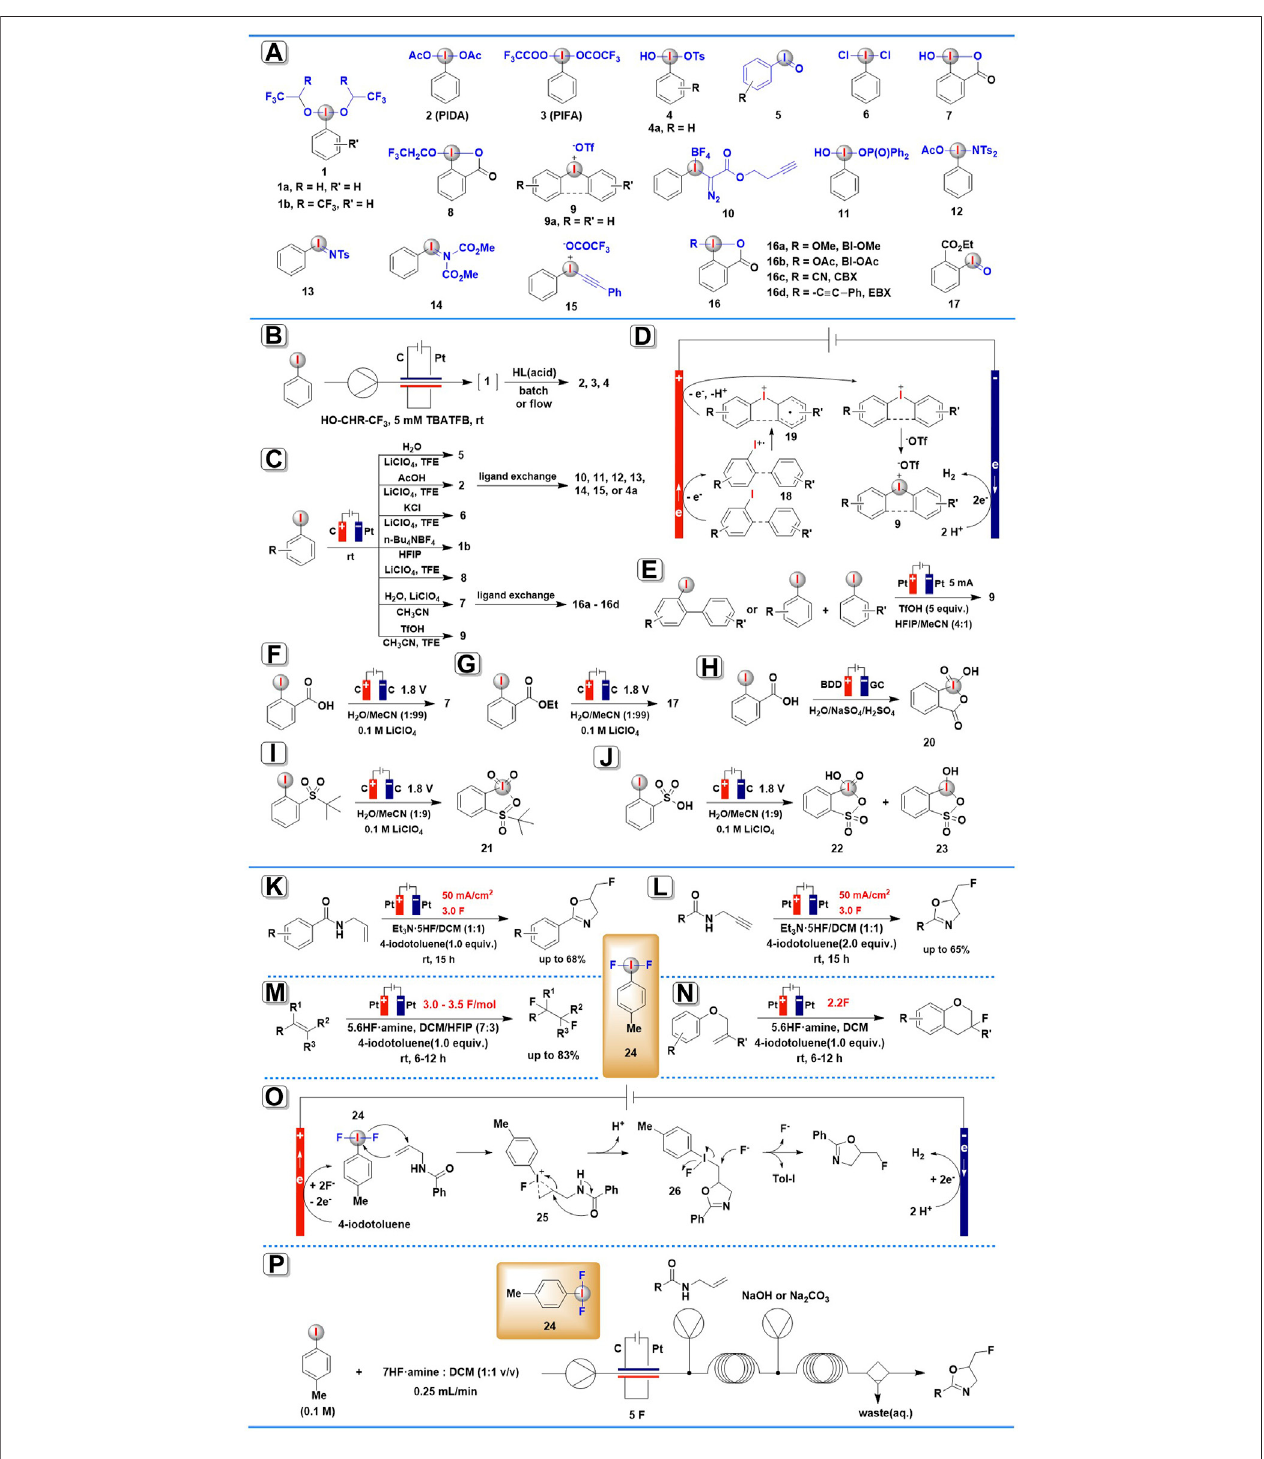
SCHEME 1 | Electrochemical synthesis of HIRs and organic transformations mediated by anodically generated (di fl uoroiodo)arene. (A) Electrogenerated hypervalent iodine derivatives. (B) The continuous- fl ow electrochemical generation of HIRs. (C) Anodic oxidation for the synthesis of aryliodine(III) reagents. (D) The possiblemechanismforelectrochemicalsynthesisofdiaryliodoniumsalts. (E) Scalableelectrochemicalsynthesisofdiaryliodoniumsalts. (F,G) Electrochemicalsynthesis of HIRs using water as the O-atom source. (H – J) Electrochemical synthesis of organic iodine (V) compounds. (K – N) Organic transformations mediated by anodically generated (di fl uoroiodo)arene. (O) The possible mechanism for electrochemical fl uorocyclization of N-allylcarboxamides mediated by ArIF 2 . (P) Fluorinations using fl ow electrolysis.